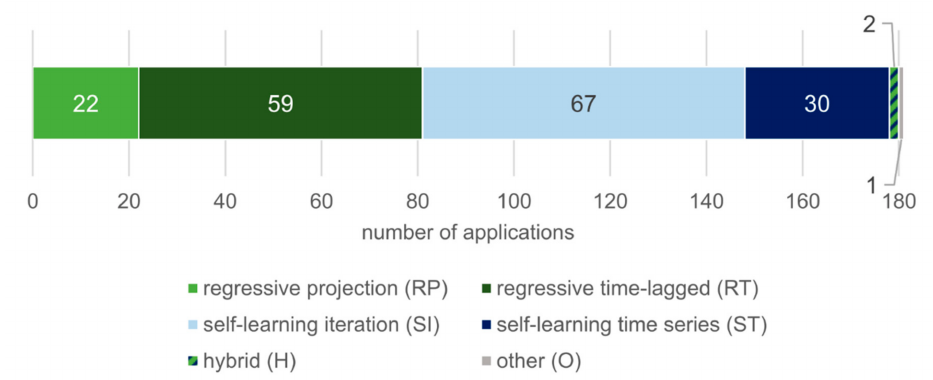
Figure 6. Number of forecasting methods used, categorized by method type. One research article may employ multiple forecasting